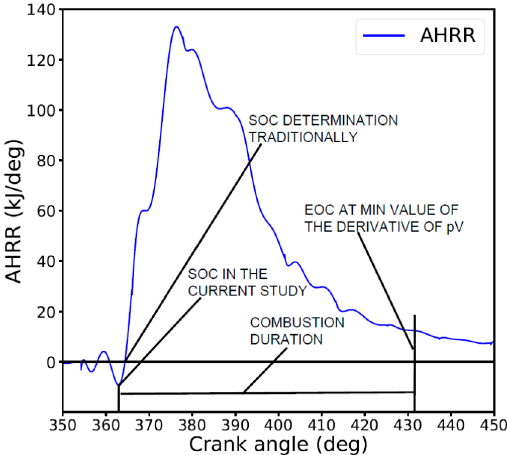
Figure 4. AHRR diagram showing SOC, EOC and combustion duration (50th cycle) at 100% load in Segment 8 of Stage 4 at 2000 rpm.